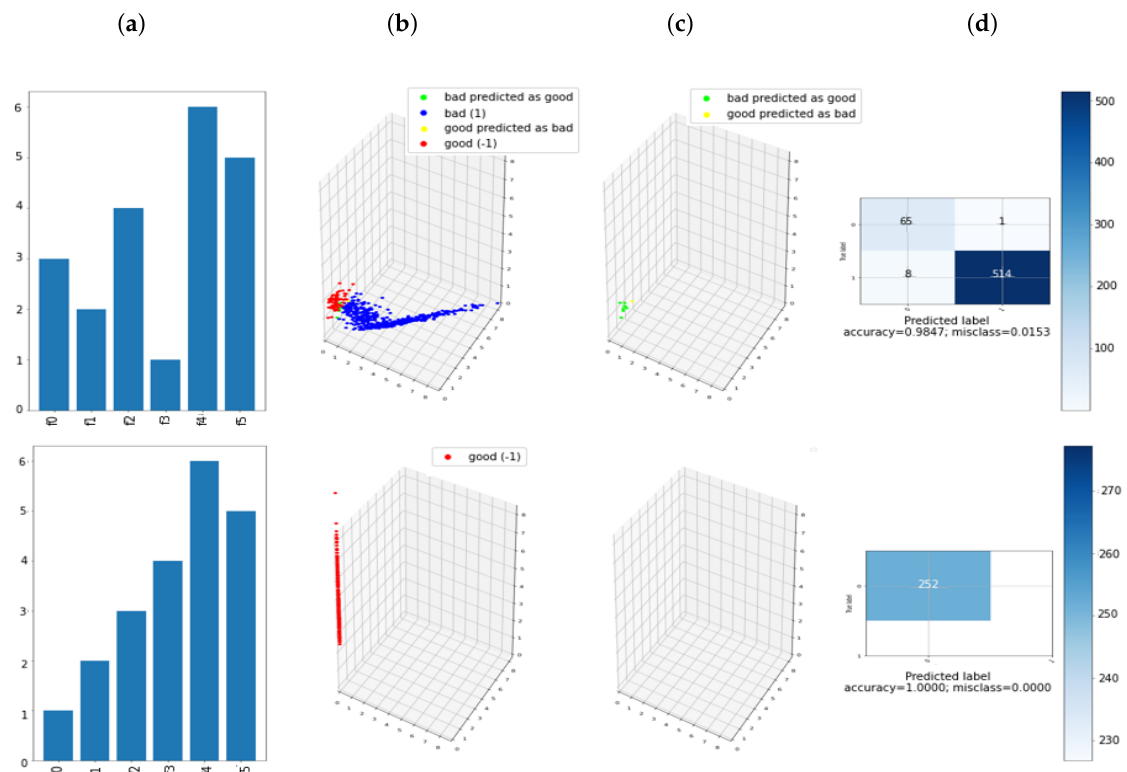
Figure 8. ITR analysis. By rows, the analysis of 2 sets of samples sharing same ITR for the synthetic dataset. By column: ( a ) represents the ITR, ( b ) latent space representation of the samples identifying the class and the AE prediction, ( c ) latent space of misclassified samples, ( d ) the confusion matrix for all the transactions sharing the same